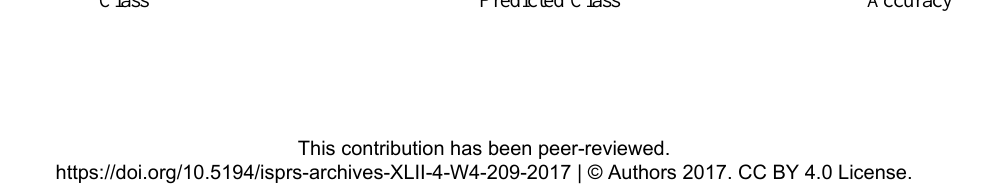
Table 2. Confusion Matrix of